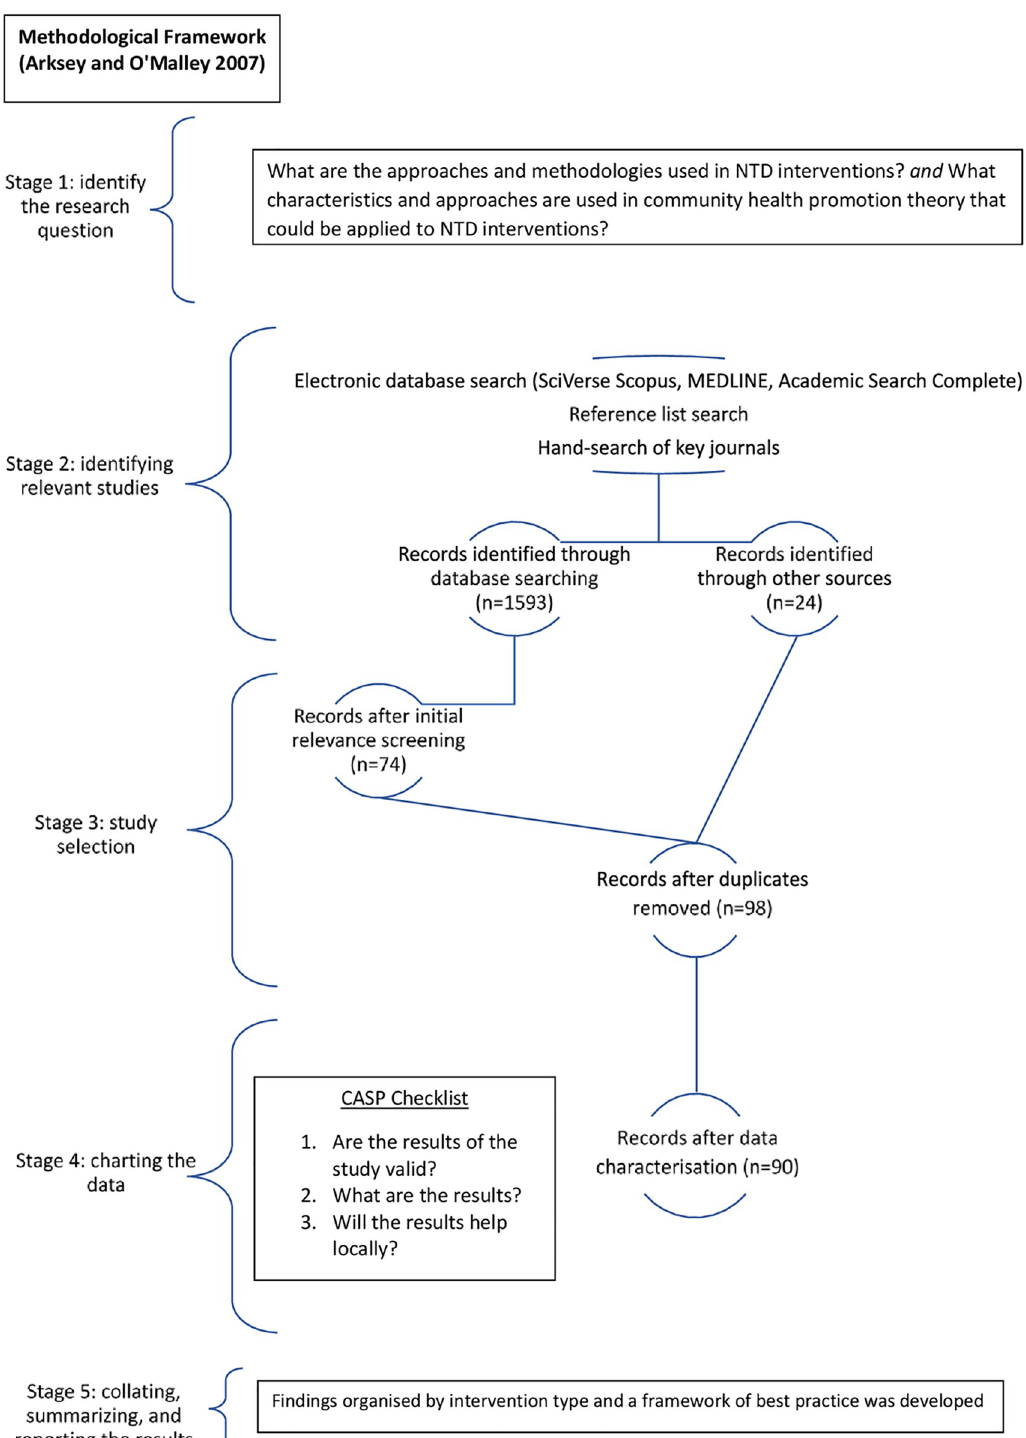
Fig 1. Flowchart diagram of total number of articles identified and selected.